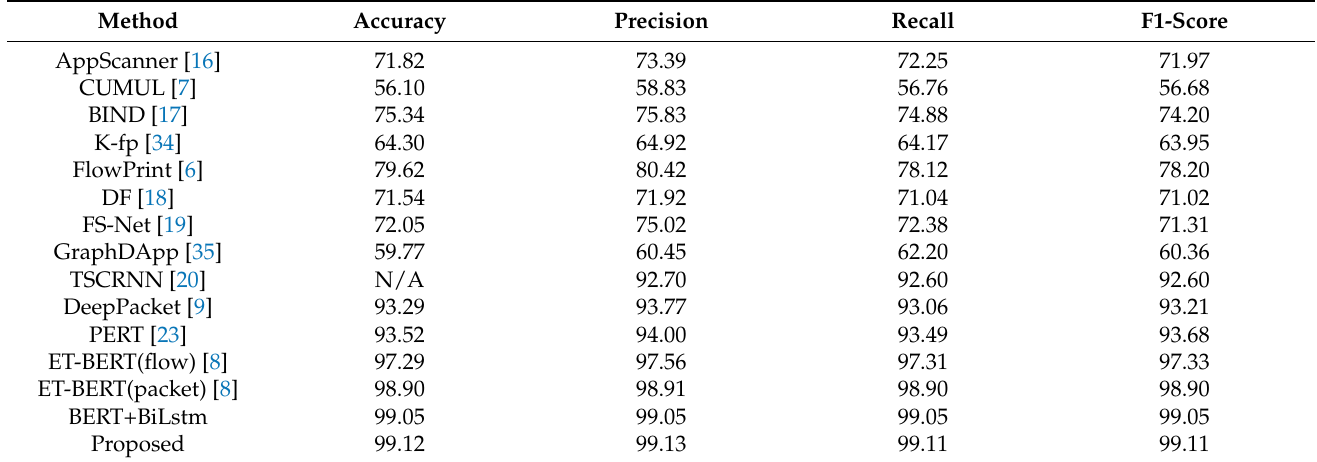
Table 6. Comparison results on service identification tasks [8].